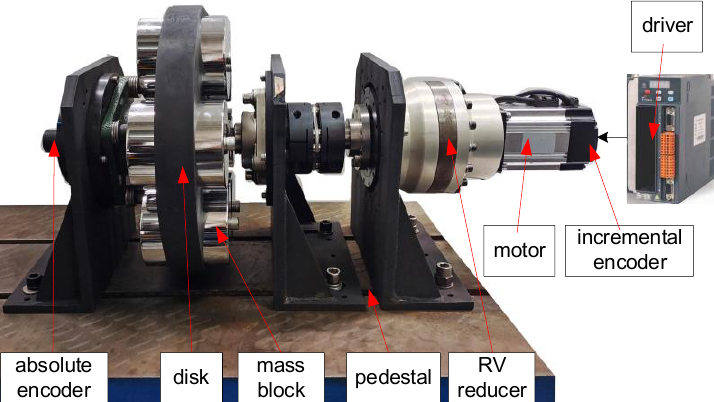
Figure 4. The experimental